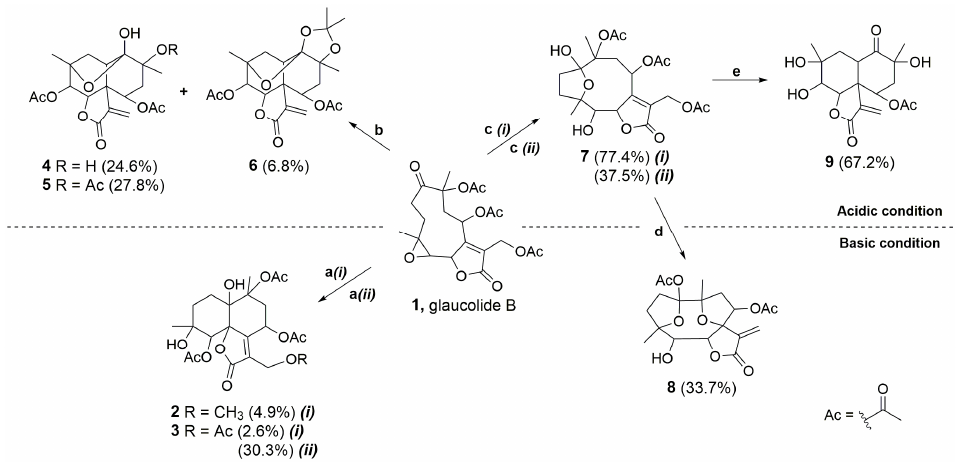
Figure 2. Acidic and basic conditions for the chemical transformation of glaucolide B ( 1 ). Reaction